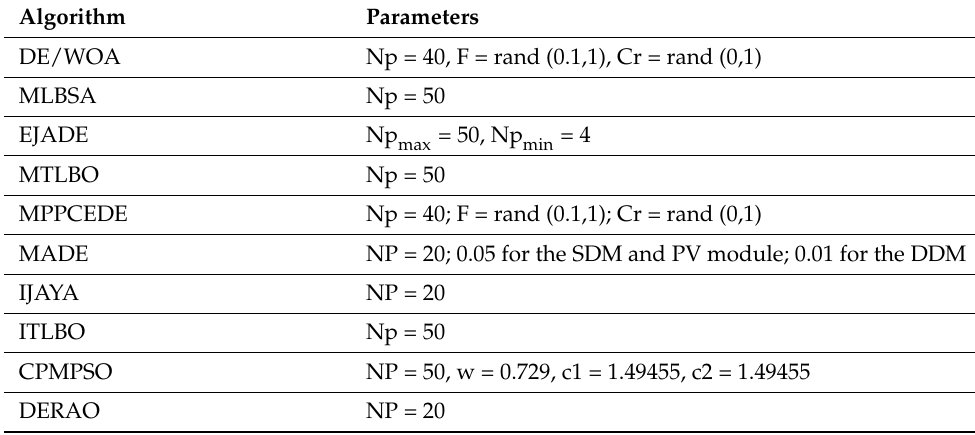
Table 4. Parameter settings of the compared